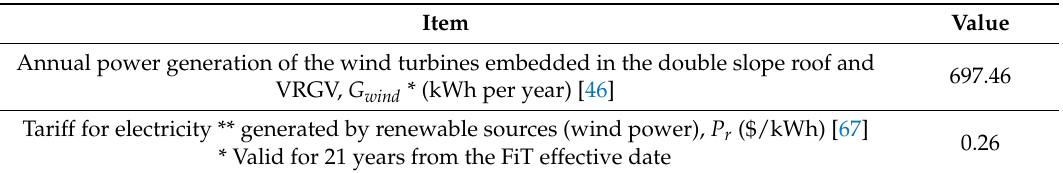
Table 11. Parameters for estimating cash flow of wind power generation.